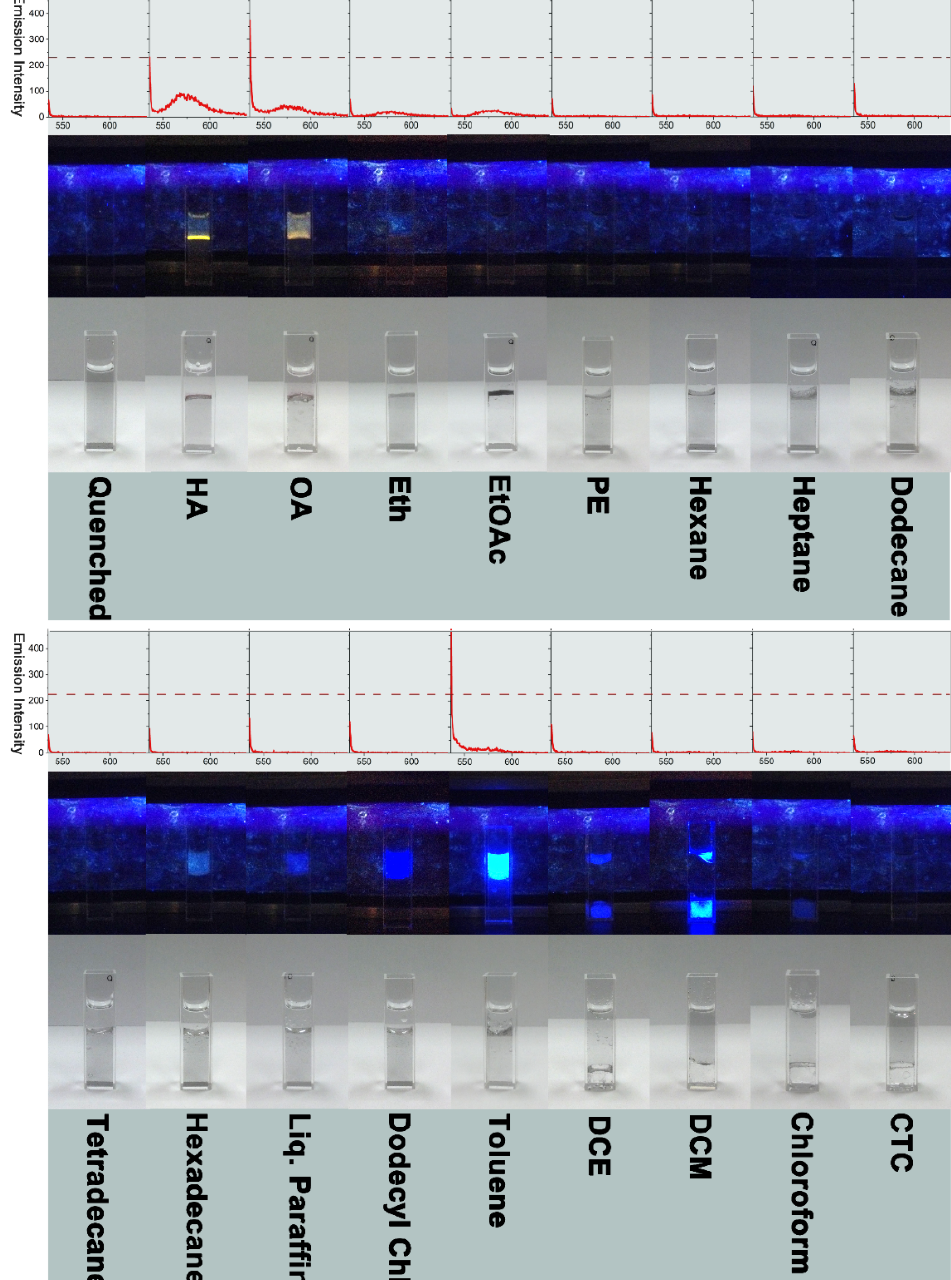
Figure 6. The fluorescence spectra (excitation wavelength of 530 nm, emission peak centered at approximately 577 nm) are shown in the top row. The corresponding photo images captured under UV light at 365 nm and day light are presented in the middle and bottom rows, respectively. The full names of HA, OA, Eth, EtOAc, PE, Liq. Paraffin, Dodecyl Chl., DCE, DCM and CTC are given as follows: HA: hexyl alcohol;